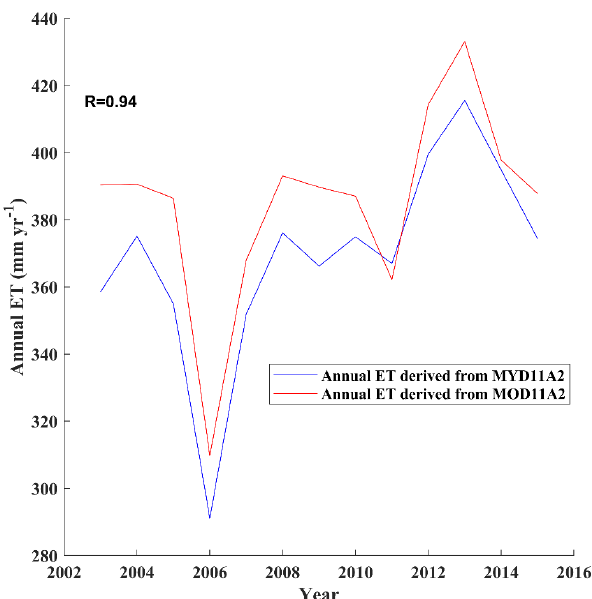
Figure A10. Monthly ET derived from the MOD11A1 and MYD11A1 in the whole YRB during the years 2003–2015.